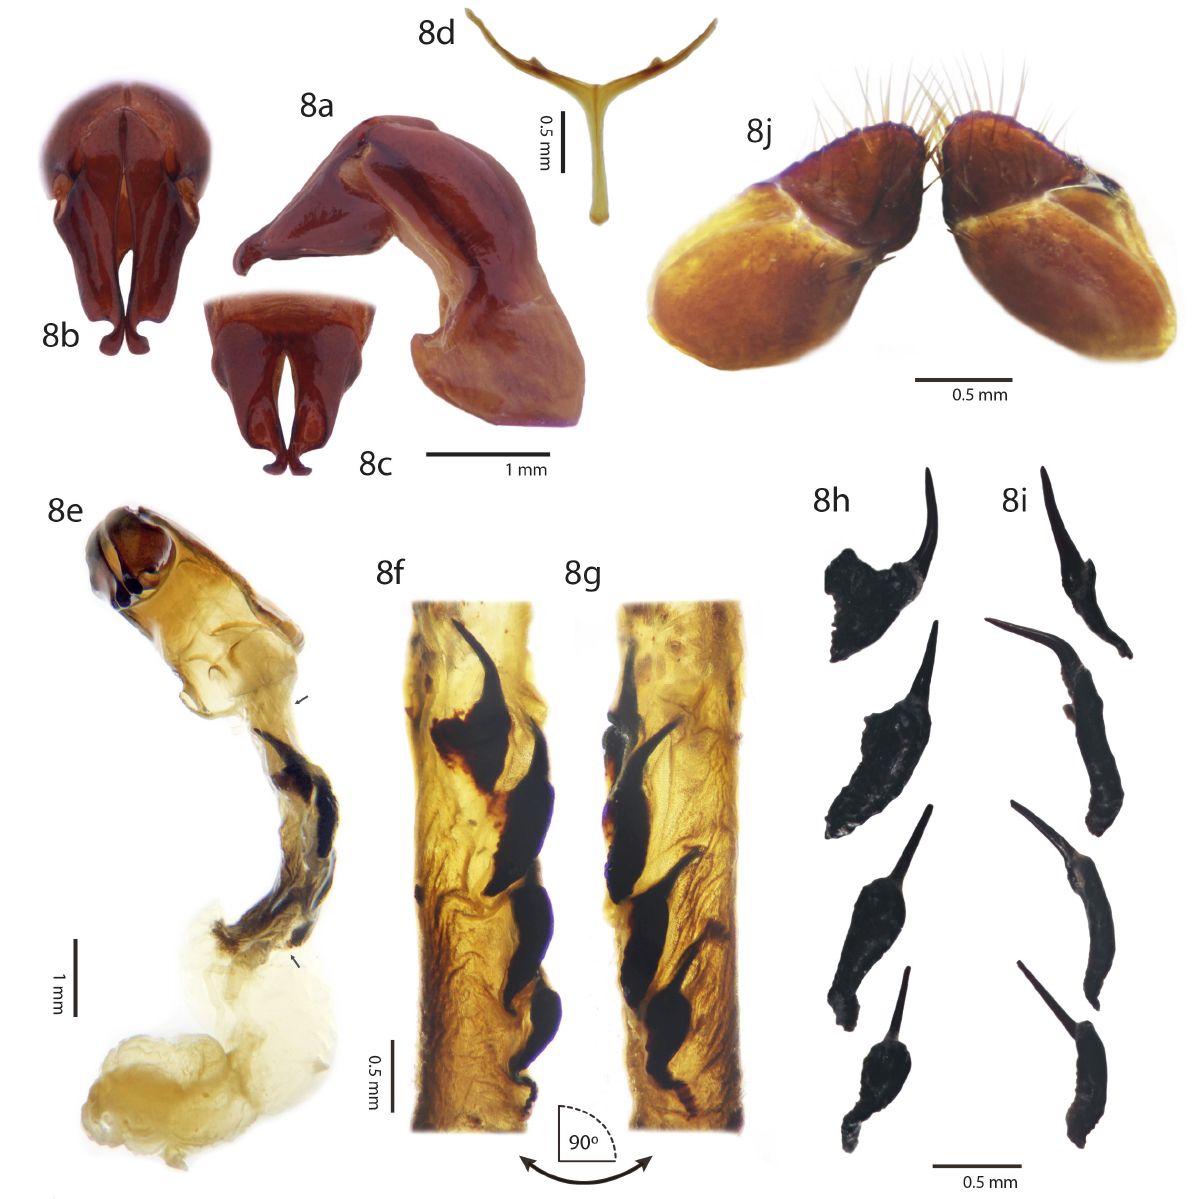
Figure 8. Stenocrates agricola , morphological characters: (a) aedeagus, lateral view. (b) Parameres, caudal view. (c) Parameres, anterior view. (d) Spiculum gastrale. (e) Parameres and internal sac. (f, g) Disposition of sclerites of internal sac. (h) Detail of sclerites of internal sac in dorsal view and (i) lateral view. (j) Gonopods IX of female in ventral